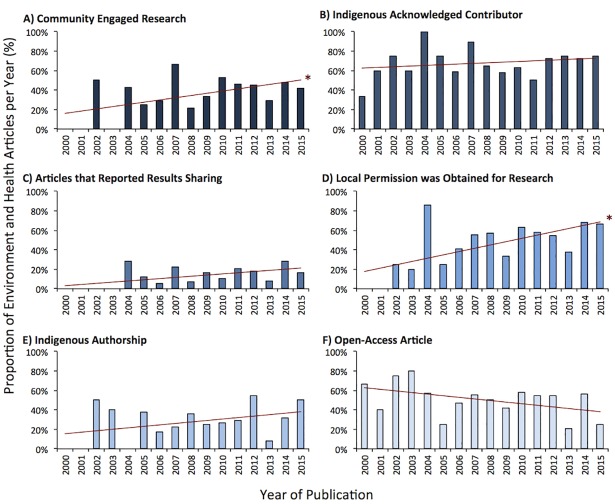
Circumpolar health and environment article attributes that indicate some form of community involvement over time with a linear trend line.Significant trends over time are marked with “*”.